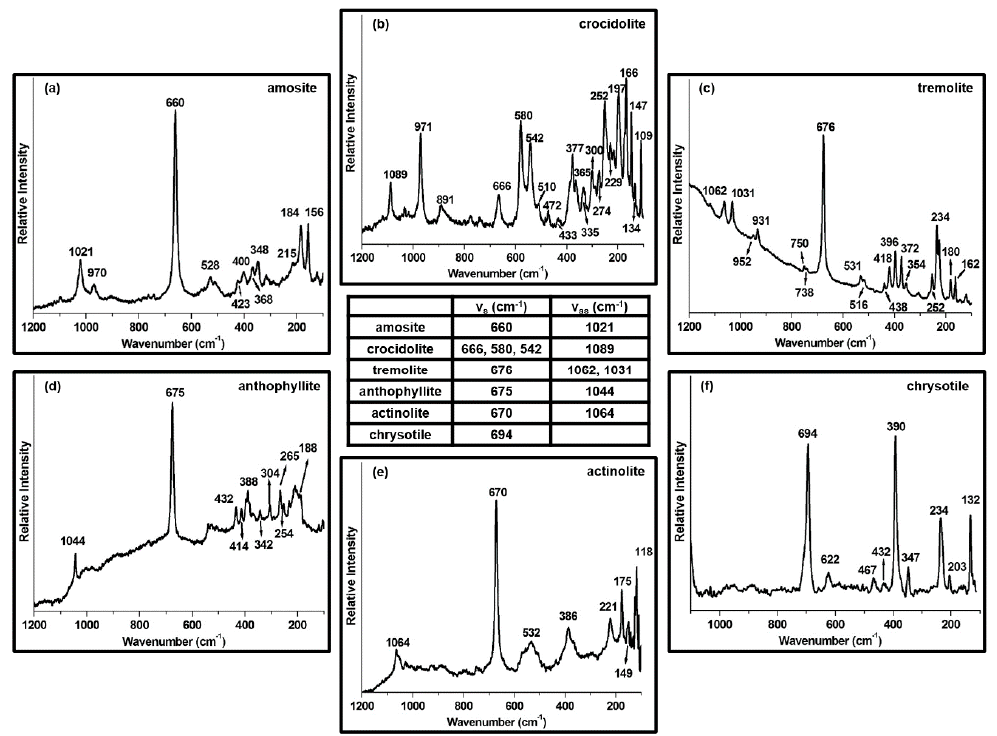
Figure 3. Spectra obtained on the six regulated asbestos minerals in the spectral range 1200–100 cm − 1 : ( a ) amosite; ( b ) crocidolite; ( c ) tremolite; ( d ) anthophyllite; ( e ) actinolite; ( f ) chrysotile. Considering the ν s and ν as modes of the Si-O b -Si bonds, a sure identification of the mineral phase can be